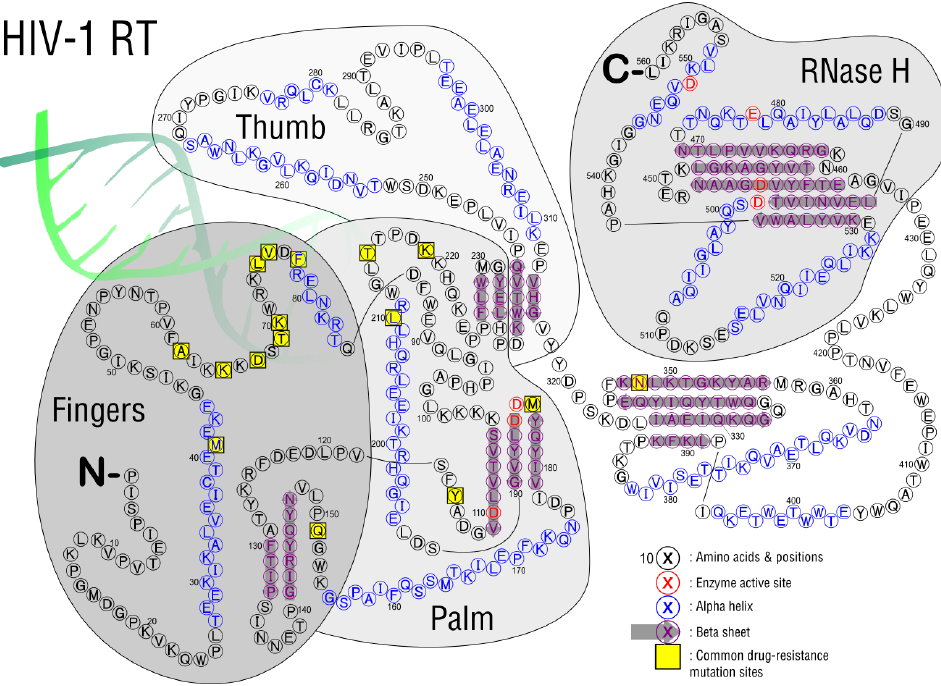
Figure 7. HIV reverse transcriptase enzyme structure in a two-dimensional map, p66 monomer. Mutational hotspots (yellow) are all found in or near the fingers and palm subdomains. In the center of the palm lies the active site residues that catalyze reverse transcription (red). The RNase H domain contains a DEDD box active site that cleaves template RNA [98]. Nucleotide strand position indicated in green. Table 3. Reverse transcription